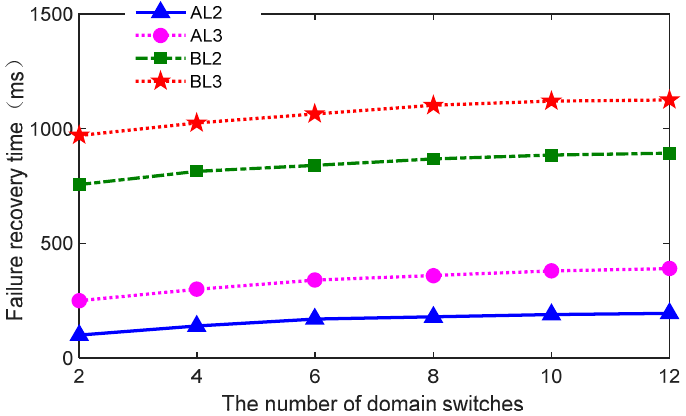
Figure 10. The relationship between the topology scale and performance.